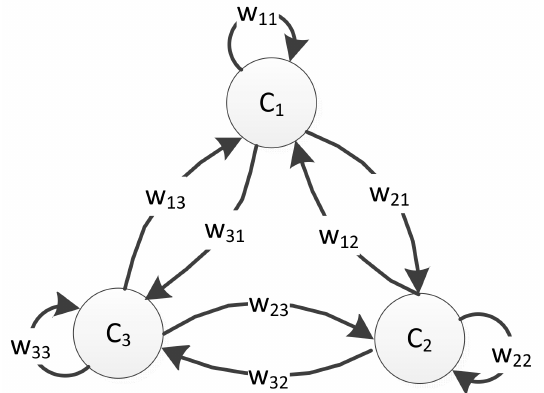
Figure 1. The framework of a fuzzy cognitive map including three